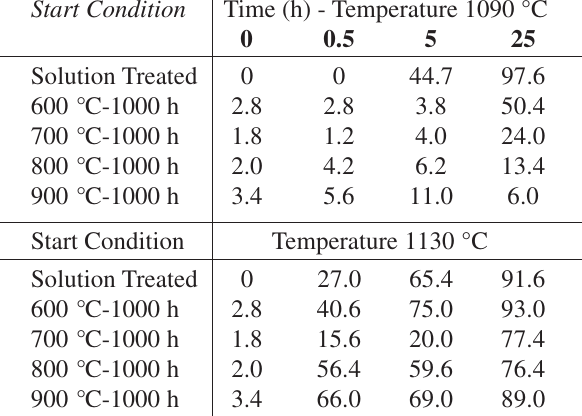
Table 1. Volumetric percentage of gross grains of the annealed samples at 1090 and 1130 ° C for various periods of time and dif- ferent start conditions (solution treated or aged at different tem- peratures for 1000